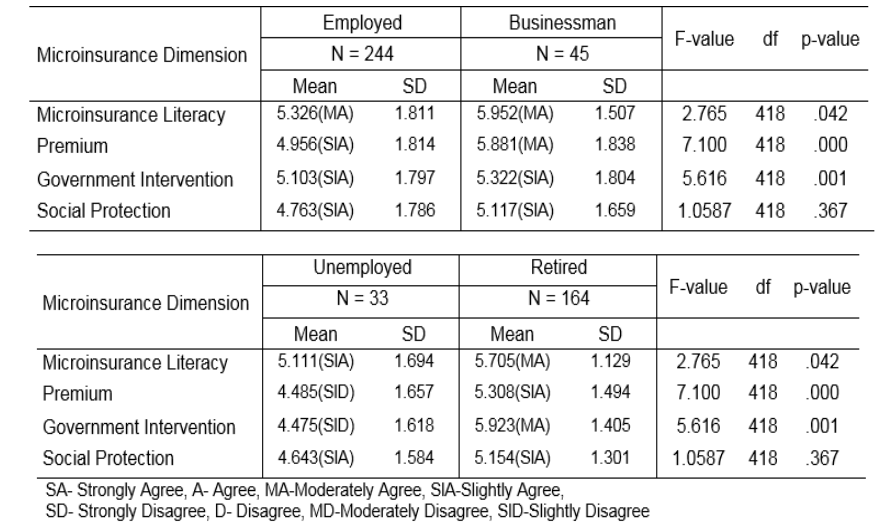
Table 10: Level of Agreement of the Respondents on the Dimensions of Microinsurance When Grouped According to Employment